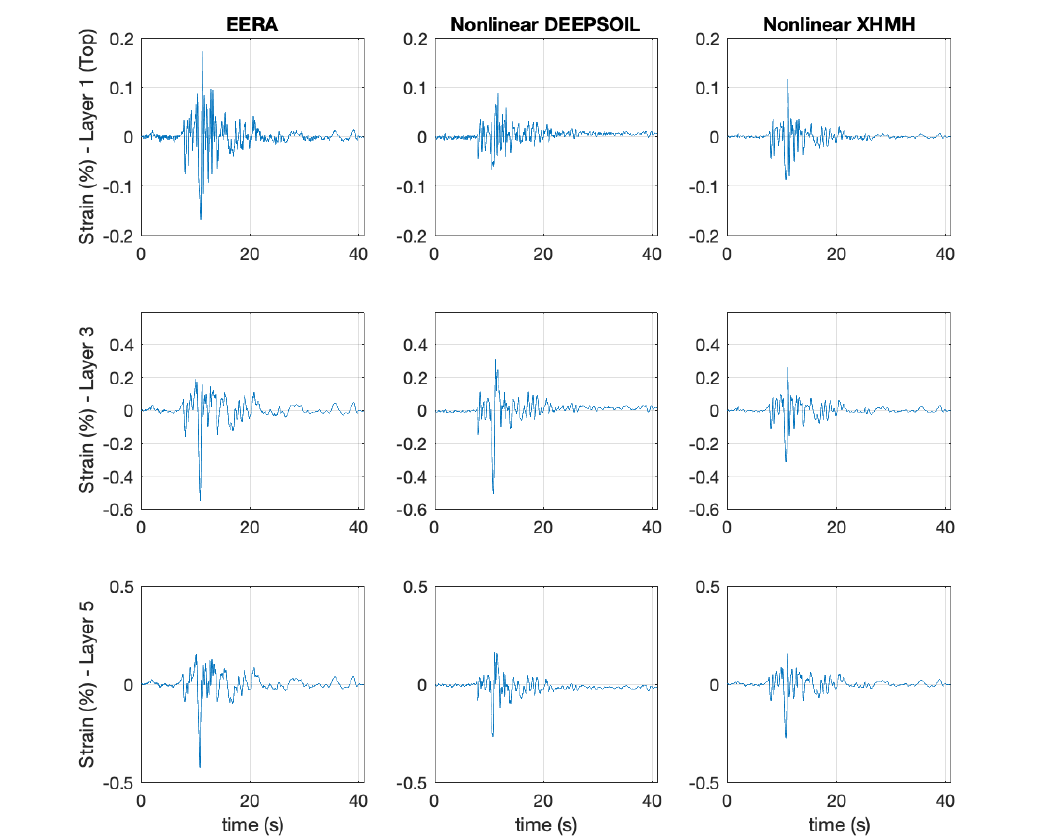
Figure 4. Shear strain time history of layer 1, layer 3, and layer 5 for the EERA, DEEPSOIL, and the truncated XHMH.